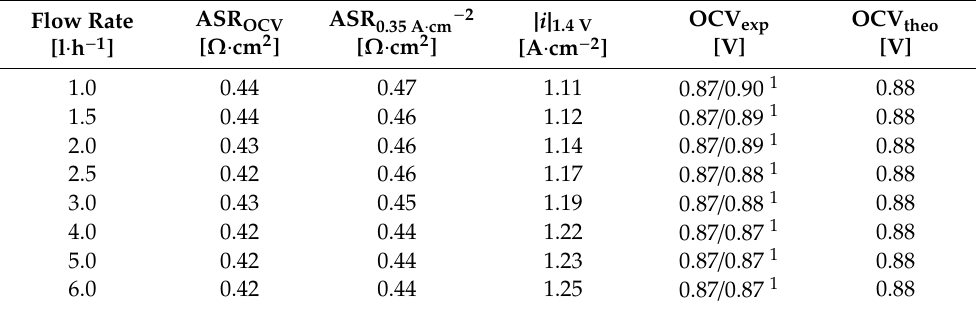
Table A3. ASR, | i | 1.4 V and OCV for varied flow rate for a CO 2 :CO ratio of 80:20 at 800 ◦